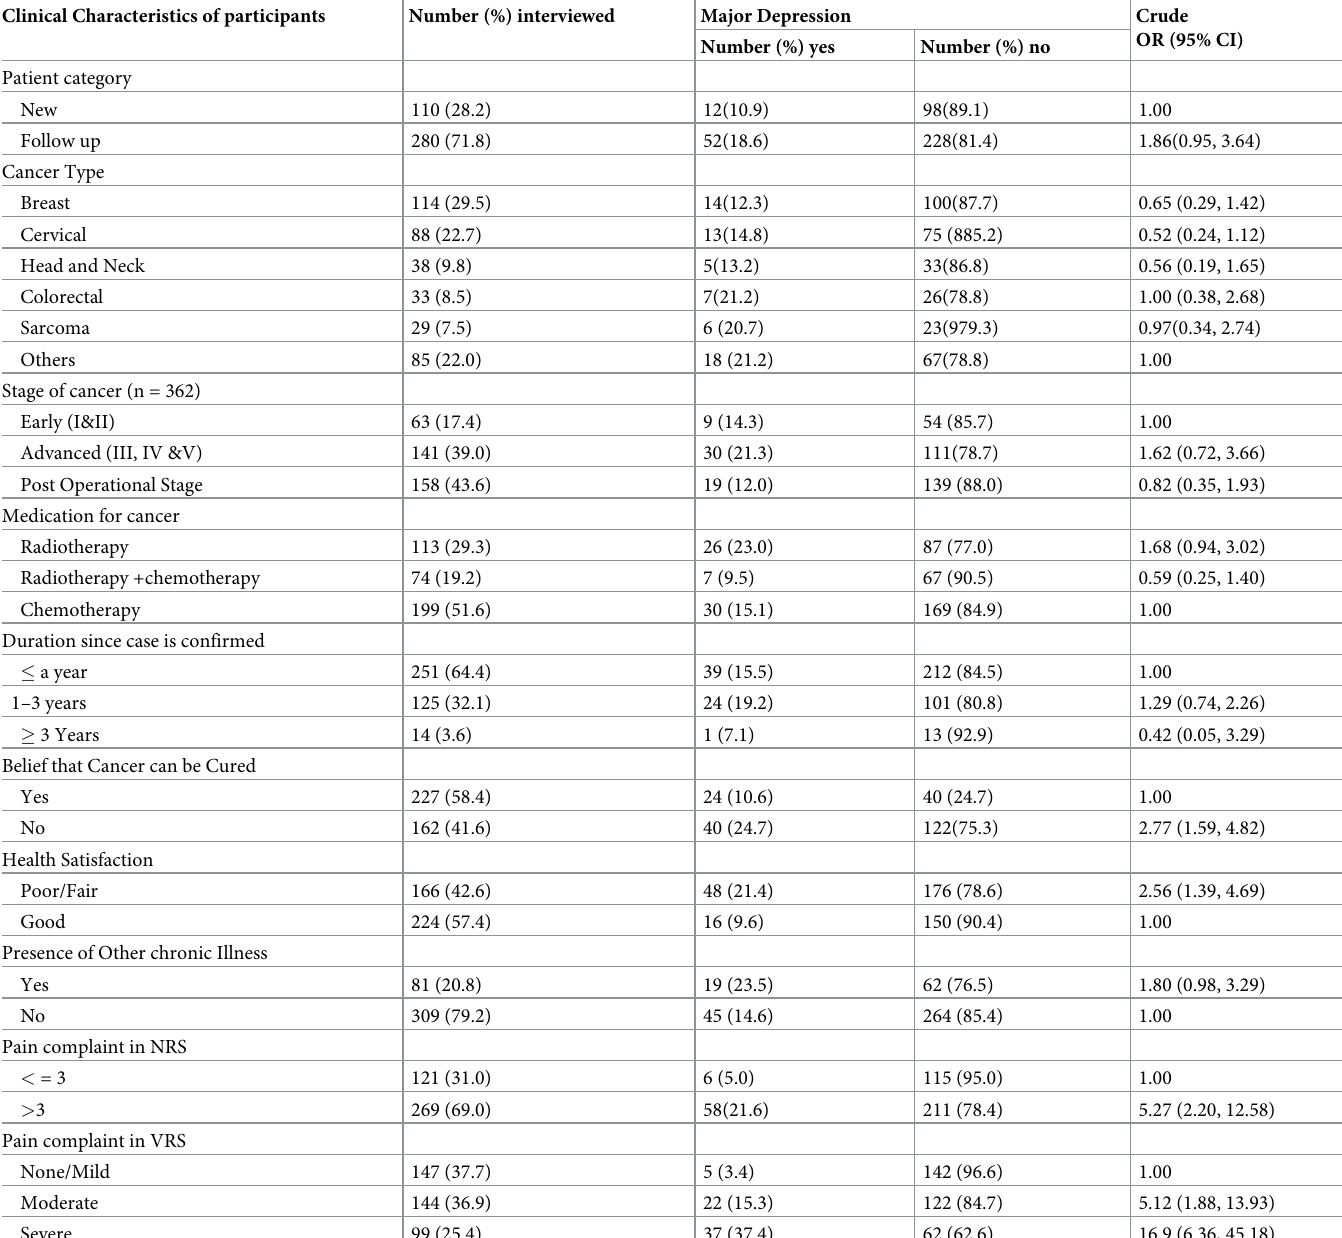
Table 3. Unadjusted effects of selected clinical indicators on the odds of having major depression. Clinical Characteristics of